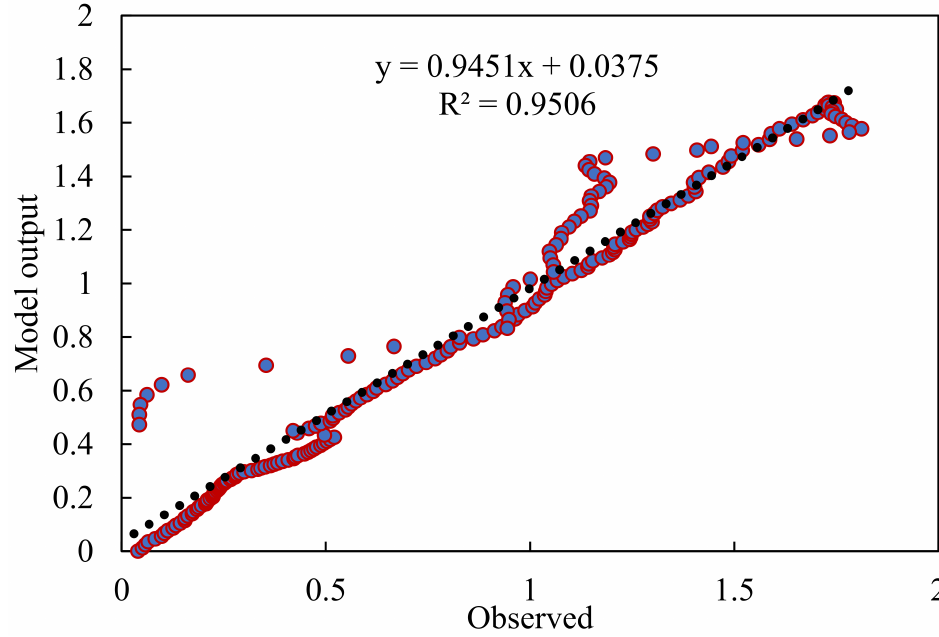
Figure 8. Cross plot of model output and observation for the gradual gas injection case.